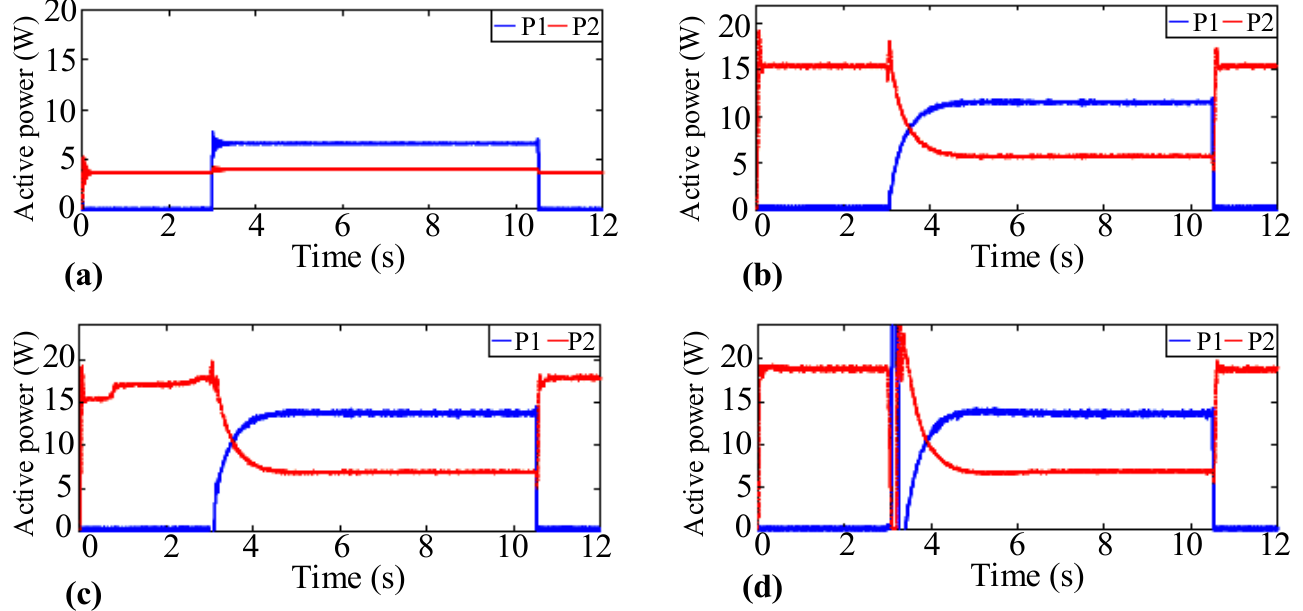
Figure 15. Active power changes in the first scenario using ( a ) the first strategy, ( b ) the second strategy, ( c ) the third strategy, and ( d ) the fourth strategy.